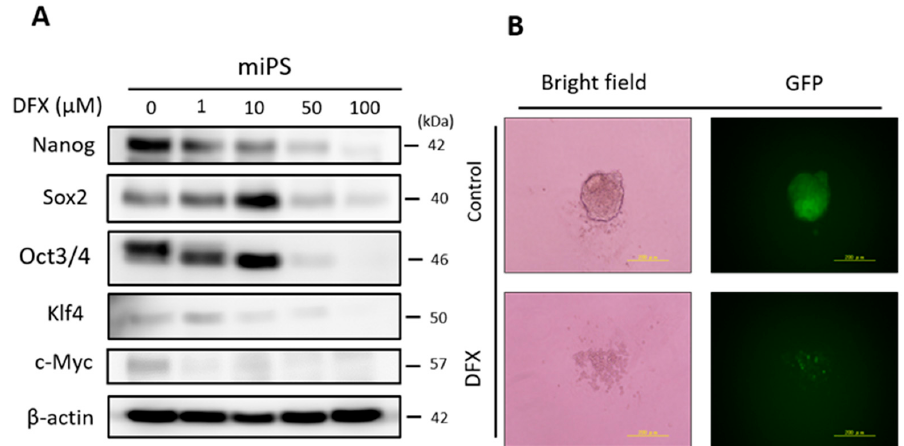
Figure 1. Cont Figure 1. Cont.